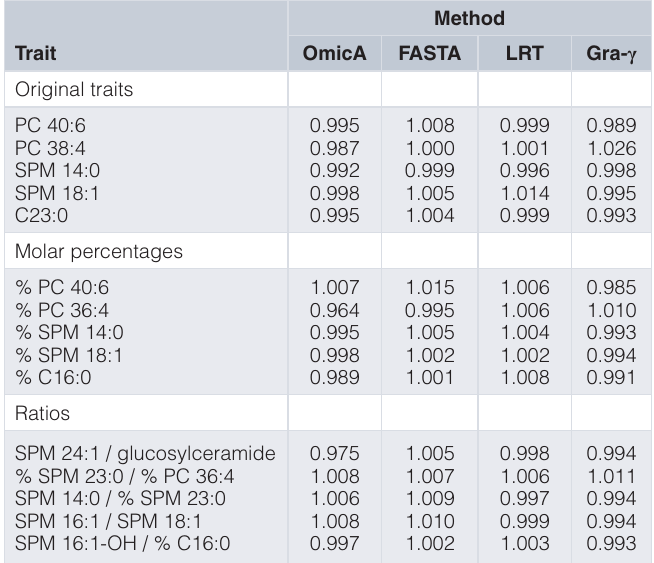
Table S5. Genomic Control λ estimates for traits analyzed in Table S4 (main